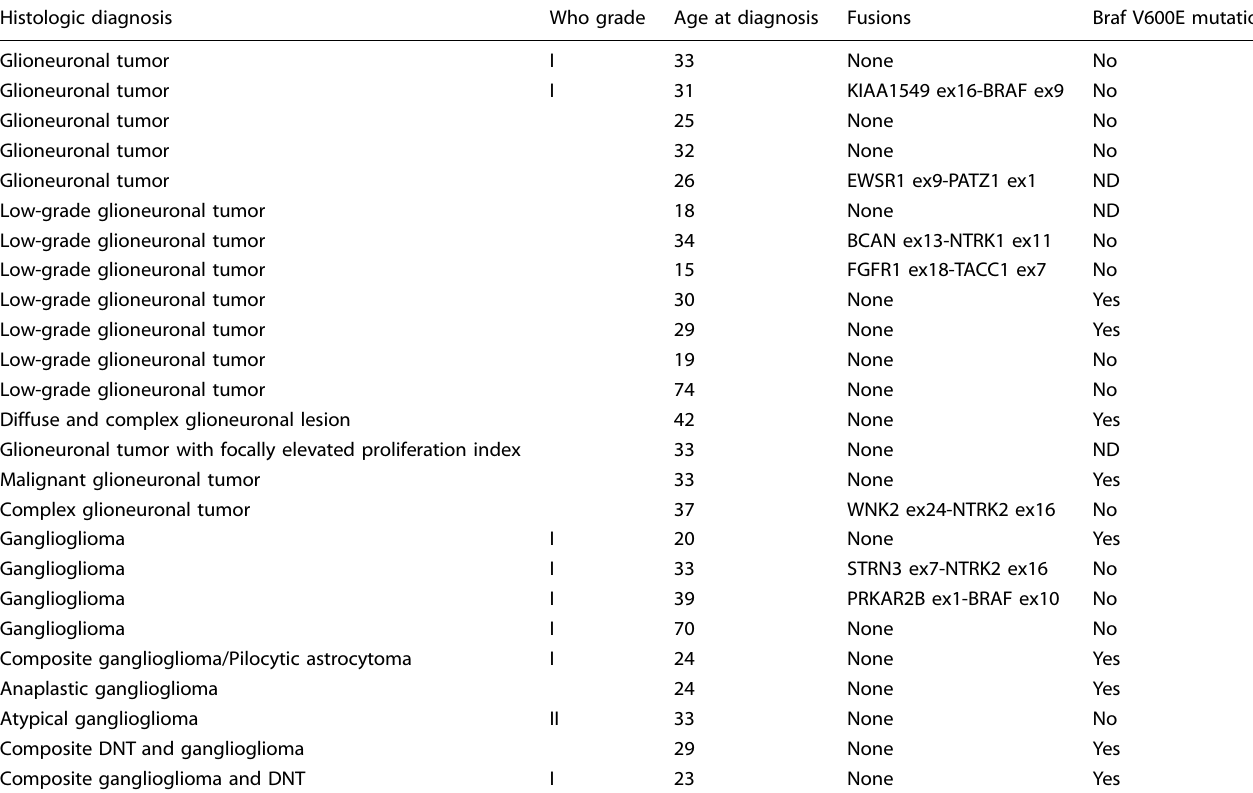
Table 1. Molecular alterations found in glioneuronal